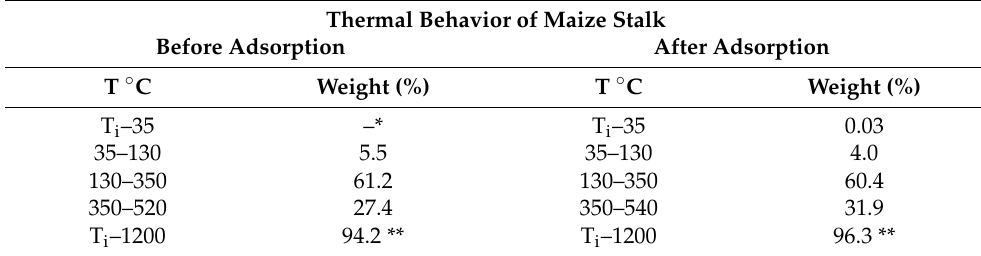
Table 7. Thermal weight loss for maize stalk before and after adsorption.